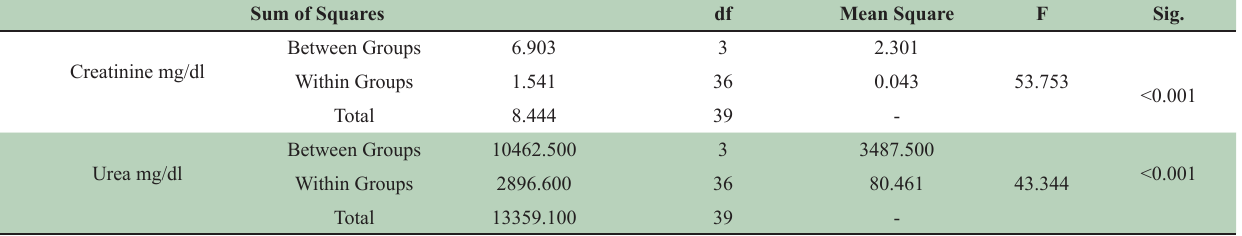
Table-II: ANOVA for comparison of means among groups.